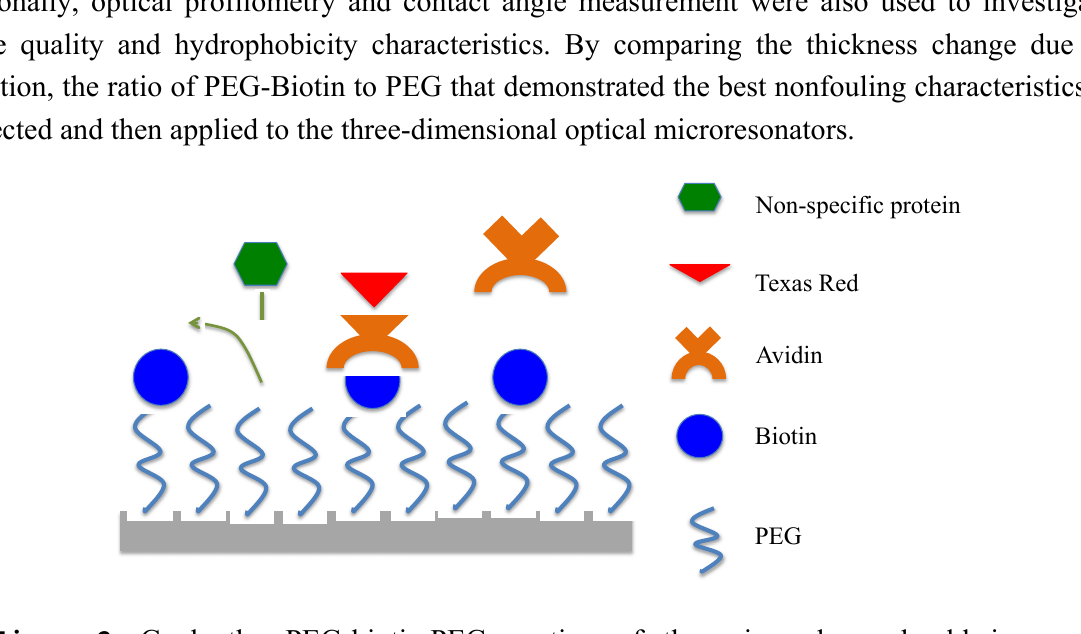
Figure 2. Goal: the PEG-biotin:PEG coating of the microsphere should improve the specificity by repelling non-specific protein adsortion. Avidin has four binding sites for biotin (two on each side); it is possible for avidin to bind 1–4 of these sites when it interacts with the surface, providing the biotin sites are within an appropriate distance. We expect avidin to bind to 1–2 biotin molecules on the surface, and present the other two binding sites to the environment; however, it is possible for a planar conformation to occur where all four sites bind the biotin tethered to the surface.